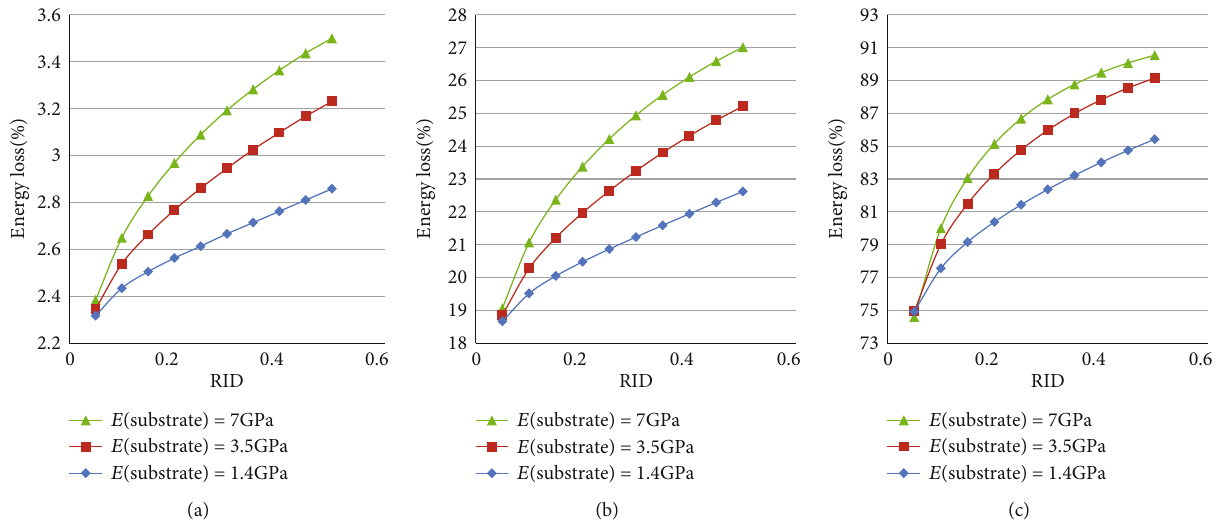
Figure 8: Energy loss of the coating/substrate system with g